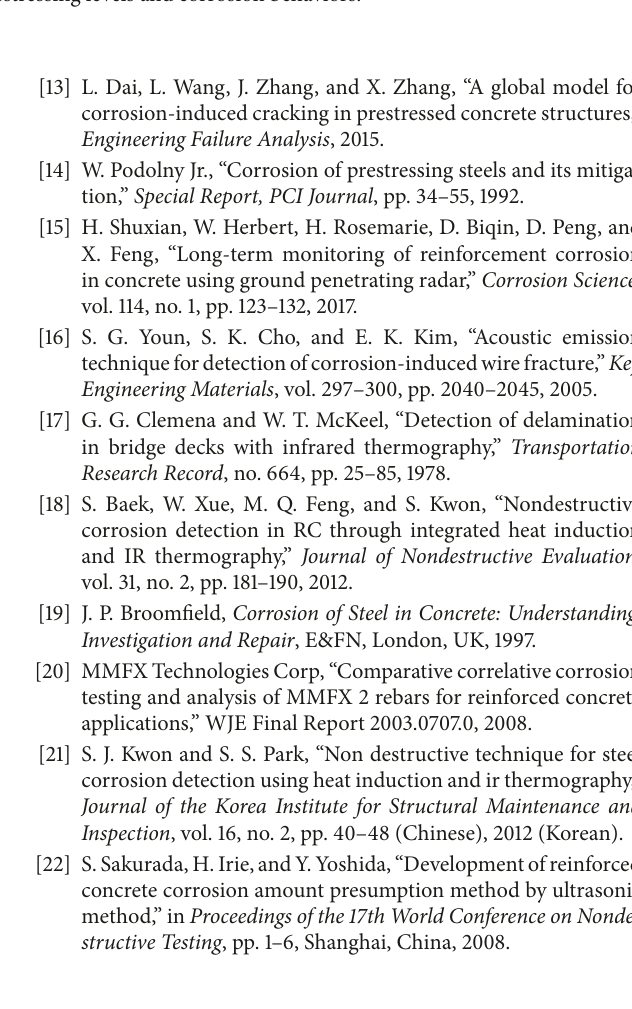
(a) Prestressing level and measured corrosion ratio in the tendon (b) Prestressing level and increasing ratio of accelerated corrosion ratio Figure 10: Relationship between prestressing levels and corrosion